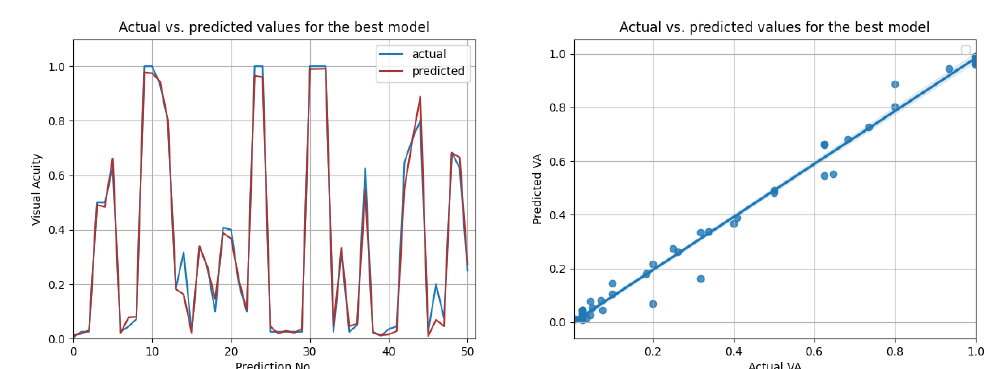
Figure 14. Actual vs. predicted VA values for the best model using all data (LSTM with R 2 = 0.99, for three previous visits). The second figure shows that the actual and predicted visual acuities are highly correlated ( r = 0.994).